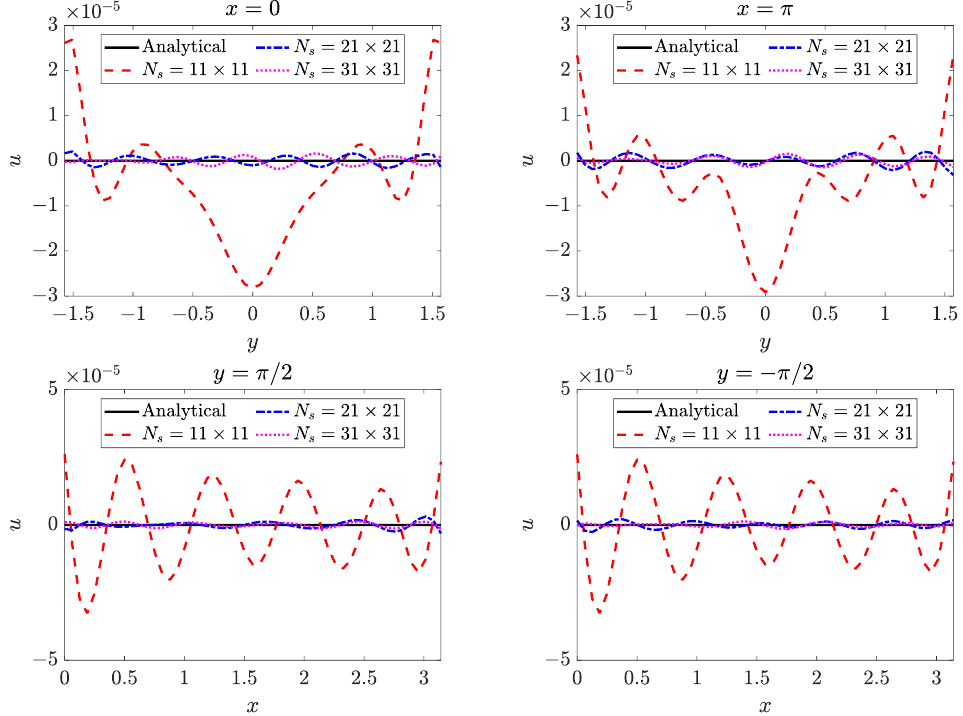
Figure 16. Boundary solutions for the 2D varying parameter identification problem.